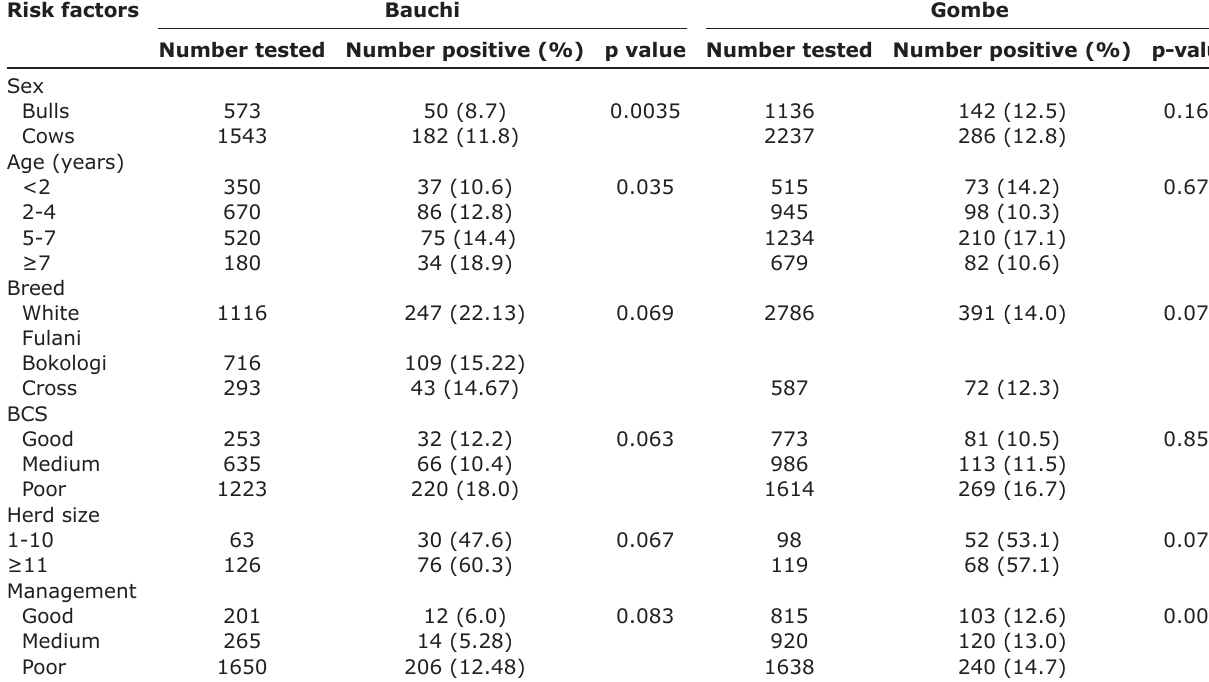
Table-3: Association between risk factors and tuberculin reactivity of cattle in Bauchi and Gombe States. Risk